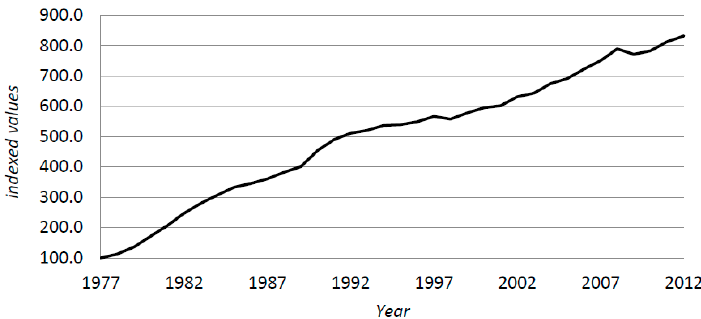
Figure 2. Trend in building cost in Naples from 1977 to 2012.